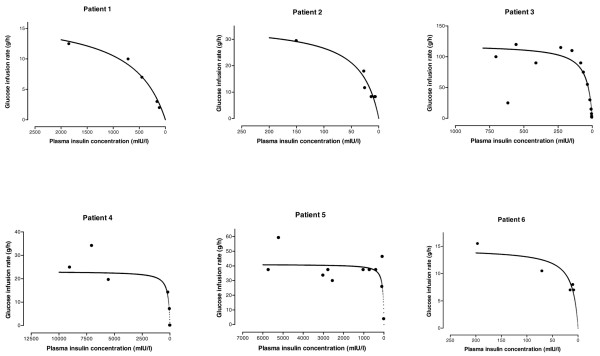
TK/TD relation between glucose infusion rate and plasma insulin concentrations. Shown are the toxicokinetic/toxicodynamic (TK/TD) relationships between glucose infusion rate and plasma insulin concentrations in six acutely insulin-poisoned patients.